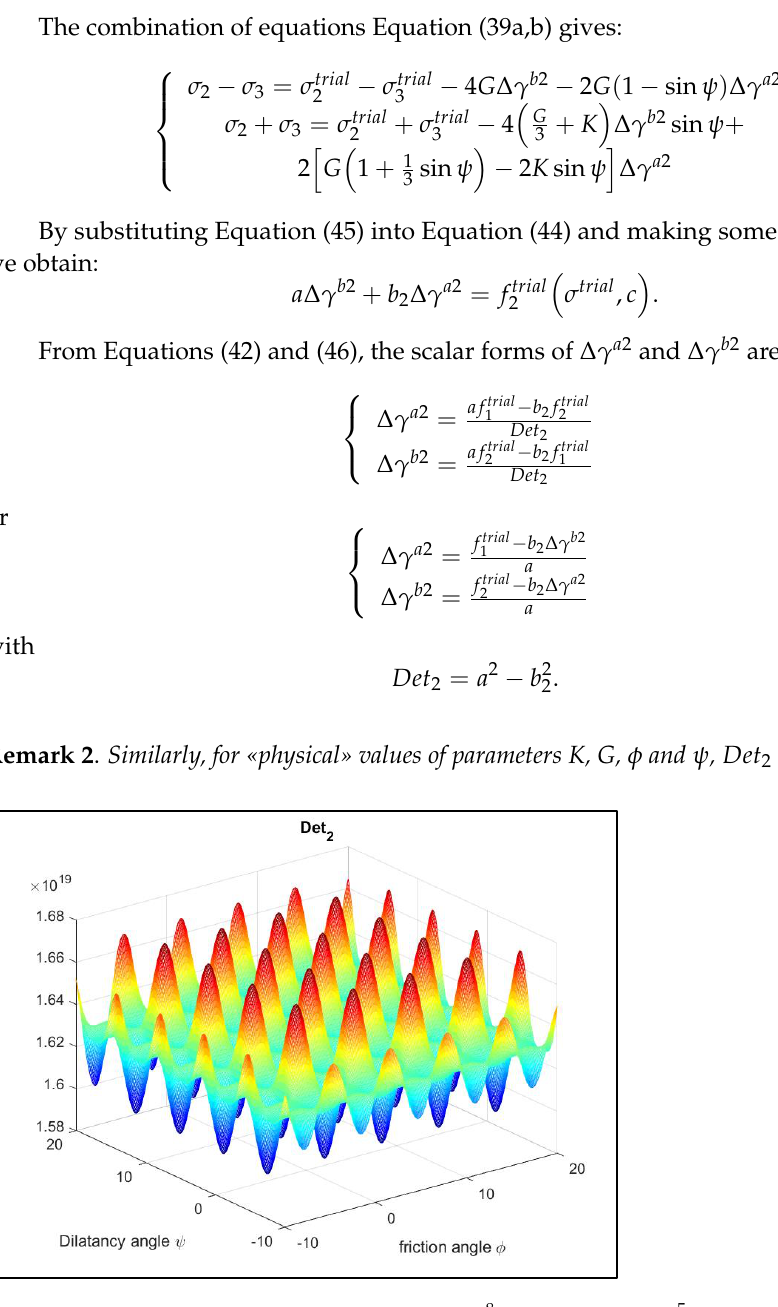
Figure 4. Example of 𝐷𝑒𝑡 2 values for K = 1.67 × 10 8 and G = 6.39 × 10 5 . The fixed-point algorithm applied to the left edge mechanism (Algorithm 5) is based on the constitutive law of the activated mechanism (Equation (39)). Its initial conditions are taken in the elastic domain ( 𝜎 1𝑡𝑟𝑖𝑎𝑙 , 𝜎 2𝑡𝑟𝑖𝑎𝑙 , 𝜎 3𝑡𝑟𝑖𝑎𝑙 , 0,0, 𝜀̅ 𝑛𝑝 = 0 ). Algorithm 5 : Fixed point algorithm applied to the left edge mechanism.